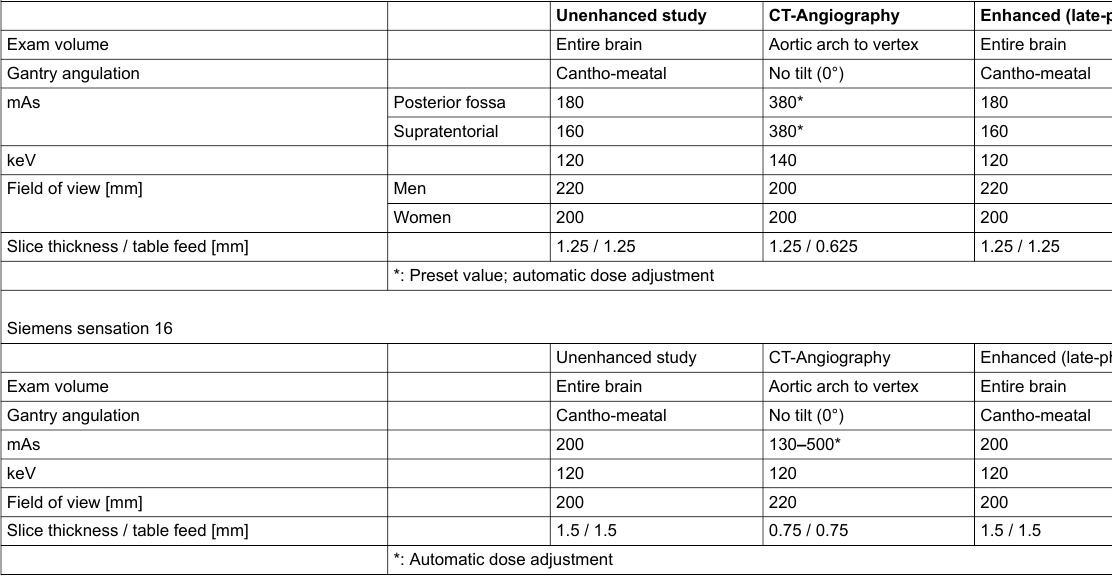
Table 2: Scored vessel evaluation for the determination of circulatory arrest. 1 point each for non-opacification of